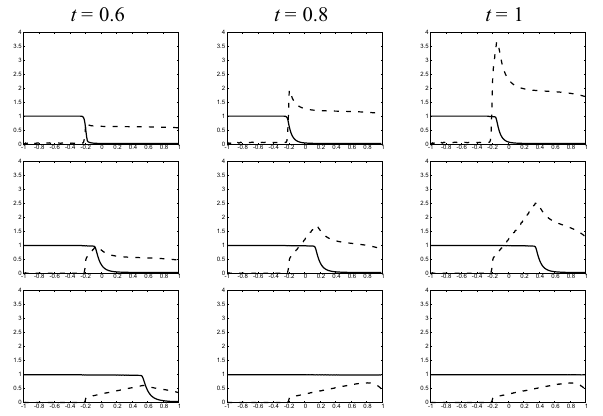
Fig. 19 Time evolution of the spatial profiles of z (solid line) and 2 (dotted line) on the line along the initial crack ( x (upper), η = 5 (middle) and η = 6